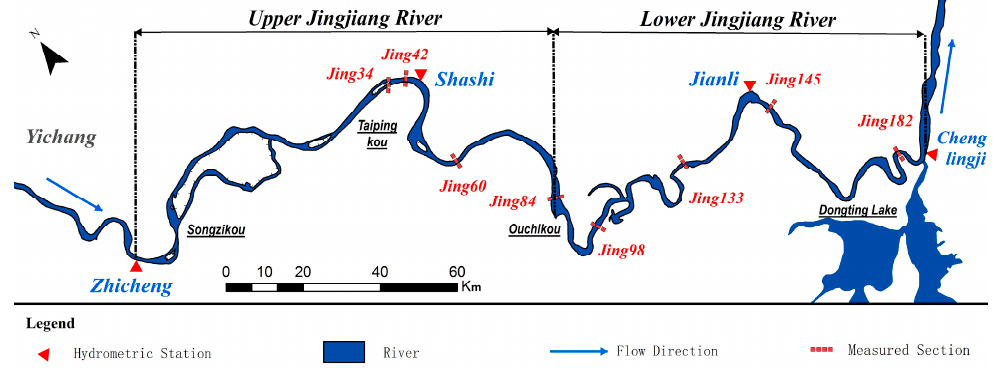
Figure 1. Sketch of the Yangtze River and Jingjiang River Reach. Table 1. Statics of data measured at the Jingjiang River Reach.